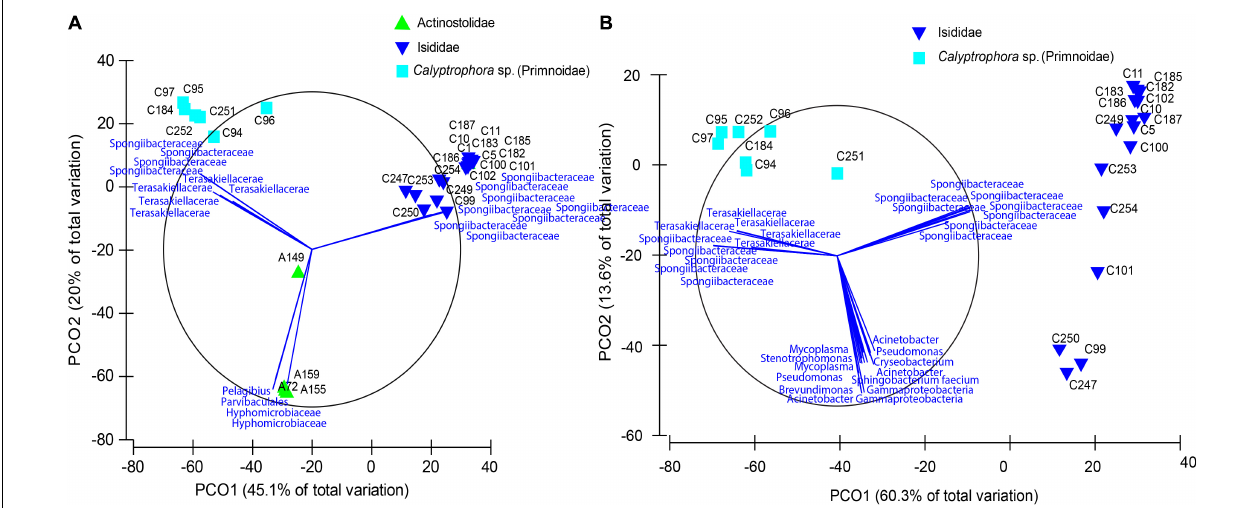
FIGURE 2 | Principal coordinate analyses plots based on a Bray–Curtis dissimilarity matrix of bacterial community compositions in anemones and coral samples. (A) Community compositions from samples belonging to Primnoidae ( Calyptrophora sp.), Isididae, and Actinostolidae families and (B) from coral samples belonging to Isididae and Primnoidae ( Calyptrophora sp.). Bray–Curtis dissimilarity metrics on the square-root transformed relative abundances were used to compare samples. Principal coordinate analysis was used for visualization purposes, and the first two components (explaining over 50% of the variation) are displayed. Vectors correspond to taxa mainly conducting sample differentiation.